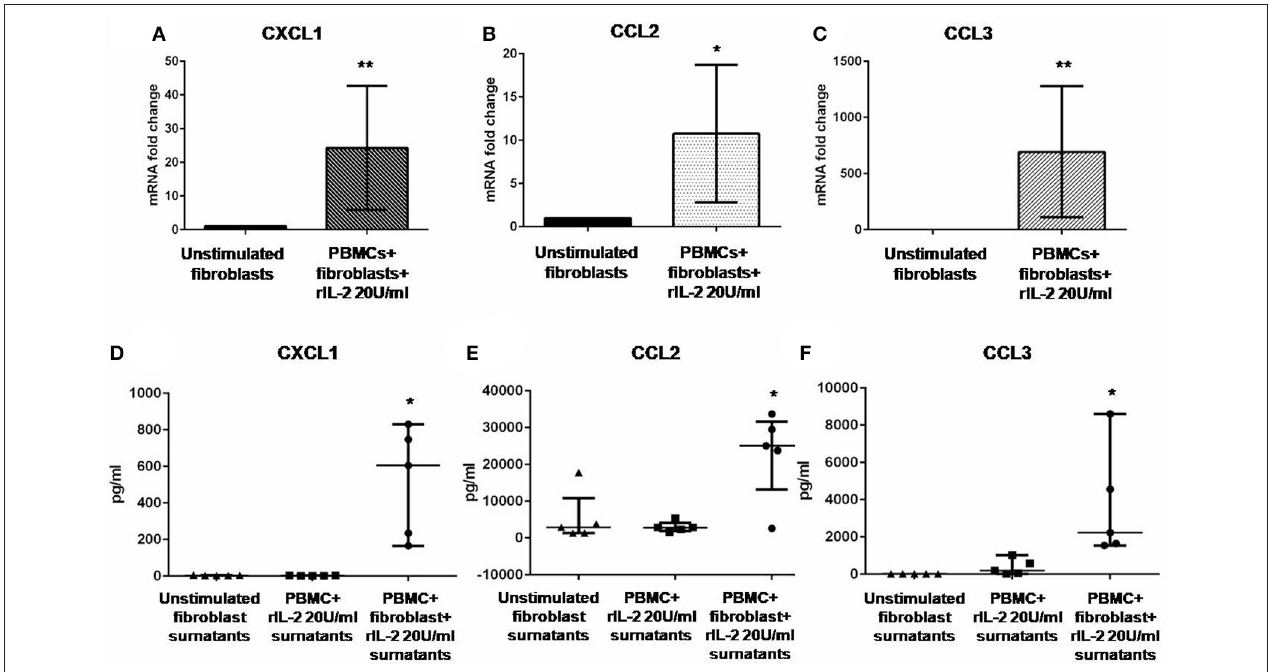
FIGURE 2 | Levels of CXCL1, CCL2, and CCL3 in co-cultured fibroblasts and supernatants from early dcSSc patients. Results in panels (A–C) are fold changes in mRNA levels of IL17A target genes in real-time PCR. Results in panels (D–F) are concentrations expressed in pg/ml, in multiple suspension immunoassay. (A–C) Show the expression of CXCL1 , CCL2 , and CCL3 in fibroblasts co-cultured with autologous PBMCs and hrIL-2 20 U/ml as compared to control fibroblasts. (D–F) Show the concentrations of secreted CXCL1, CCL2, and CCL3 in supernatants from co-cocultures and hrIL-2 20 U/ml as compared to supernatants from control fibroblasts after adjusting by concentrations measured in PBMCs cultured with hrIL-2 20 U/ml only. Data are median and IQR ranges, Wilcoxon signed rank test. * p < 0.05; ** p < 0.01; number of samples per group = 5.